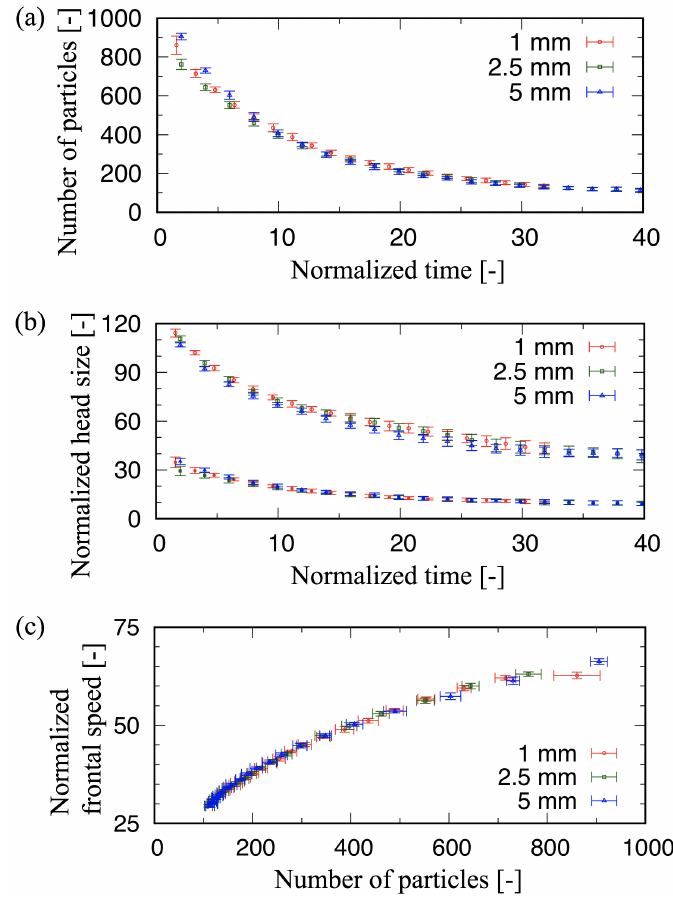
Figure 9. Time evolutions of head size defined by n (cid:48) in Equation (11b) in the circular setup. The mean and standard deviation of 20 simulations are denoted by a point and an error bar, respectively. ( a ) Number of particles constituting the head (blue and green particles in Figure 8c). ( b ) Width and thickness of head normalized by particle radius, ˜ w h and ˜ l h . The open and filled points denote ˜ w h and ˜ l h , respectively. ( c ) Relationship between the number of particles constituting the head and normalized frontal speed ˜ v f , as shown in Figure